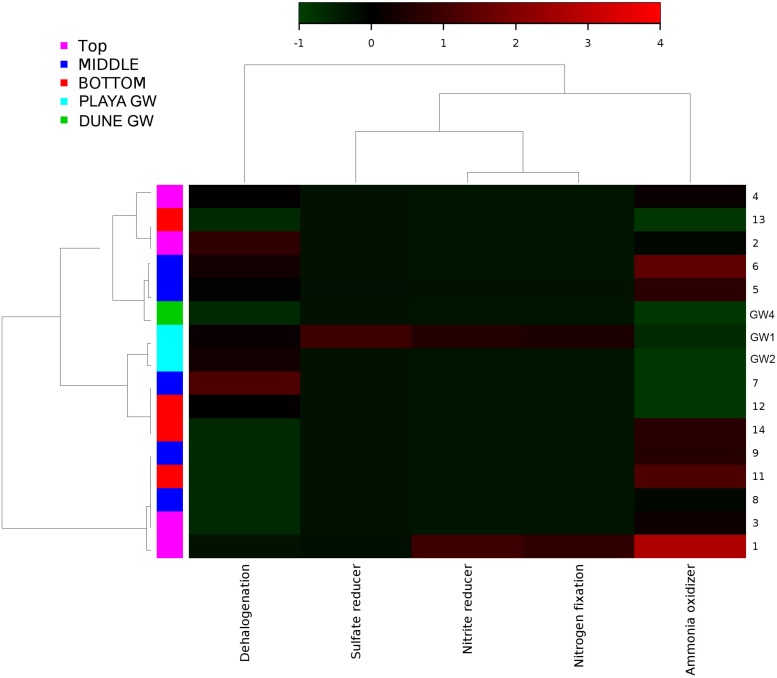
Heatmap of archaeal metabolic potentials constructed from 16S rRNA-based taxonomic identities. The color scale represents relative intensity of each metabolic pathway, with red being the highest and the green the lowest.